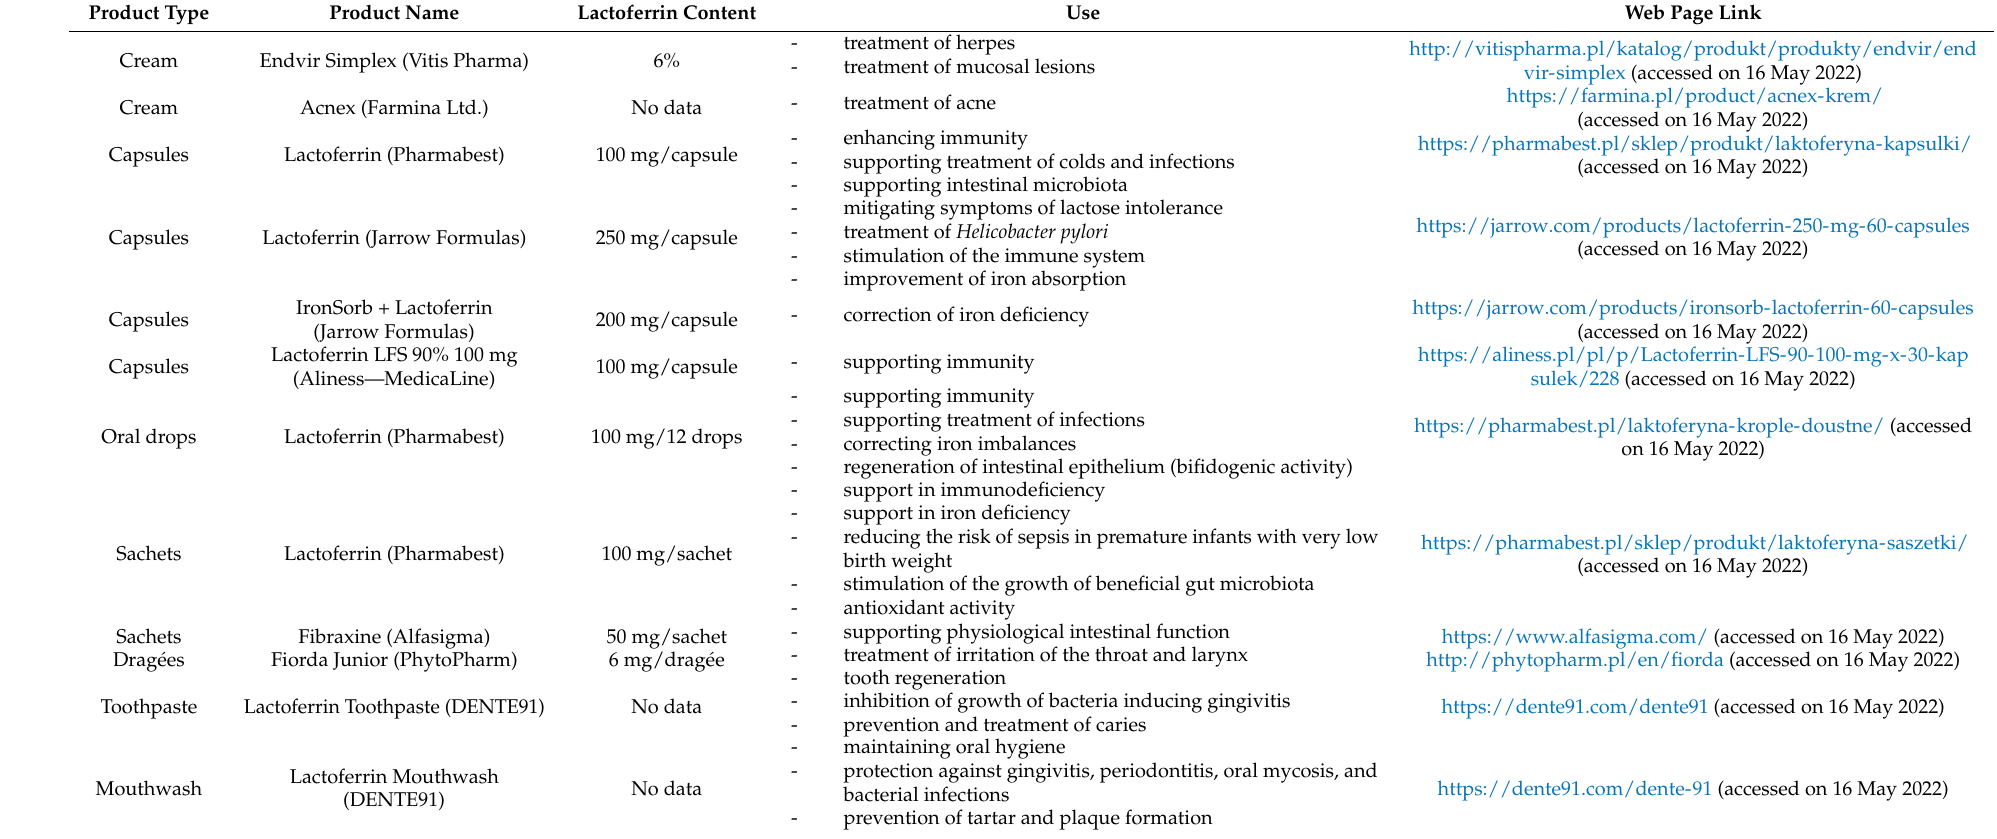
Table 5. Use of LF in pharmaceutical products and cosmetics (own